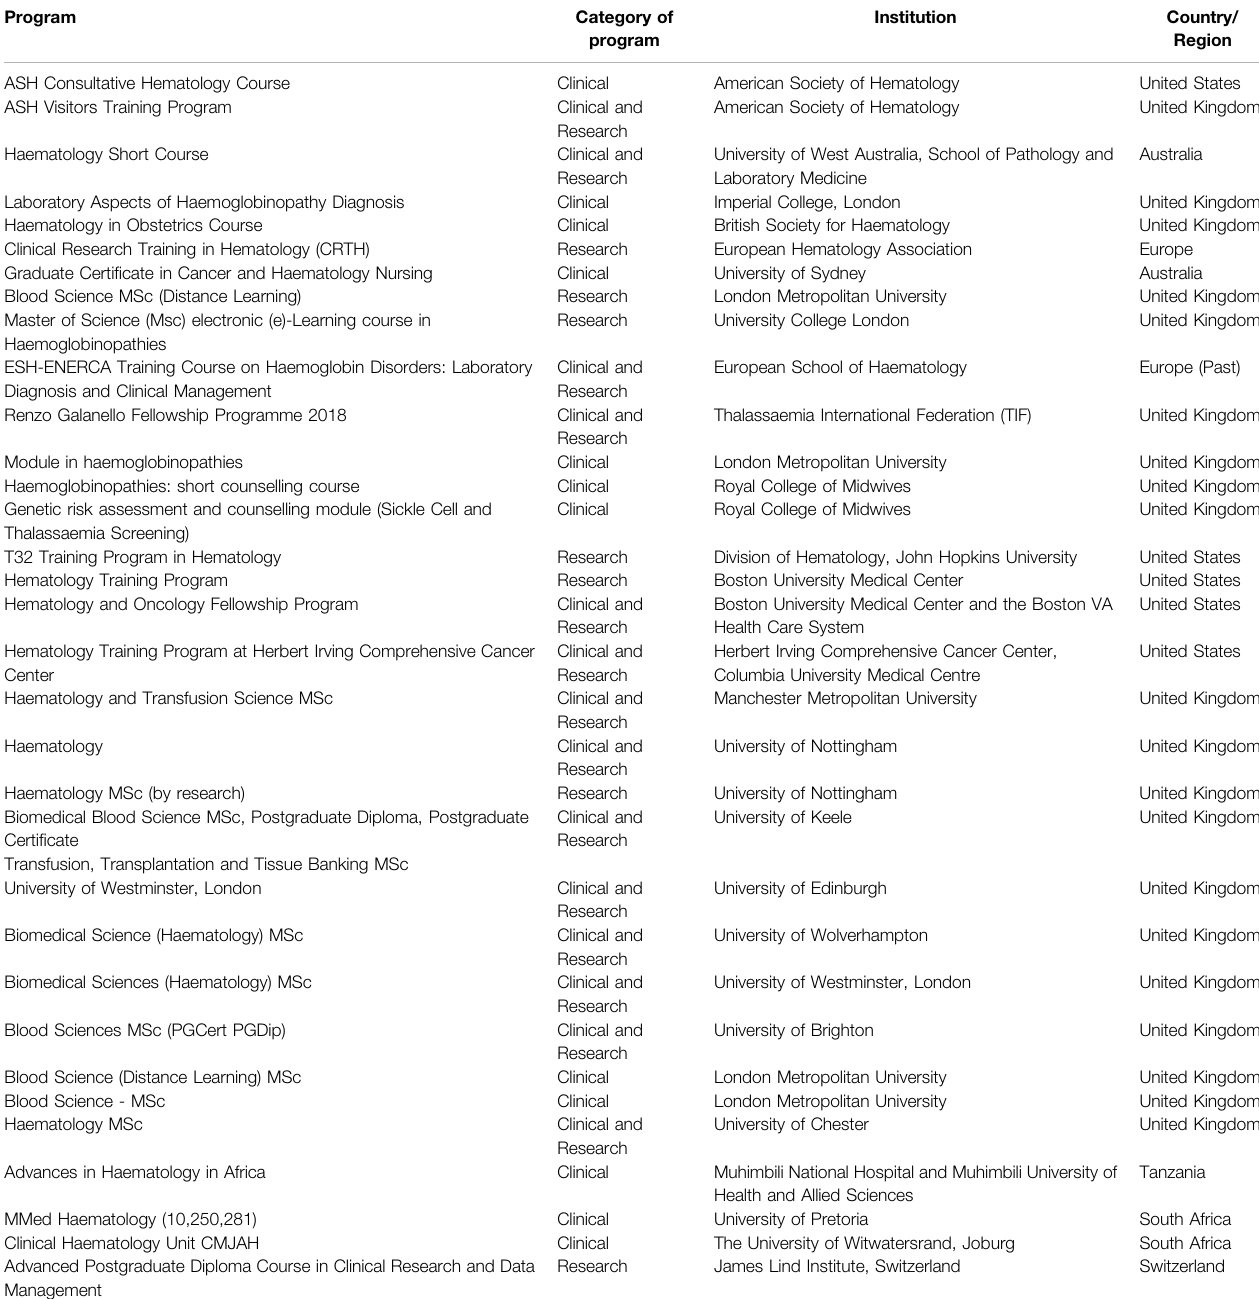
TABLE 1 | Selected courses identi fi ed in priority